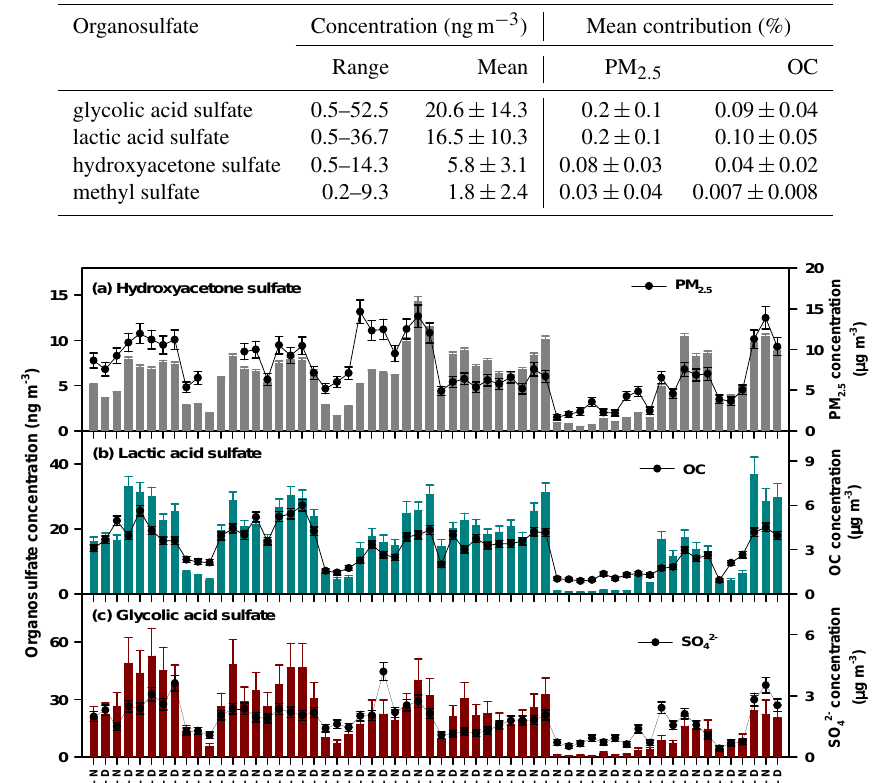
Table 1. Concentration (range and mean ± one standard deviation) of each organosulfate quantified against authentic standards from 13 June to 13 July 2013 in Centreville, AL, and their mean contribution (%) to PM 2 . 5 and OC ( ± one standard deviation).